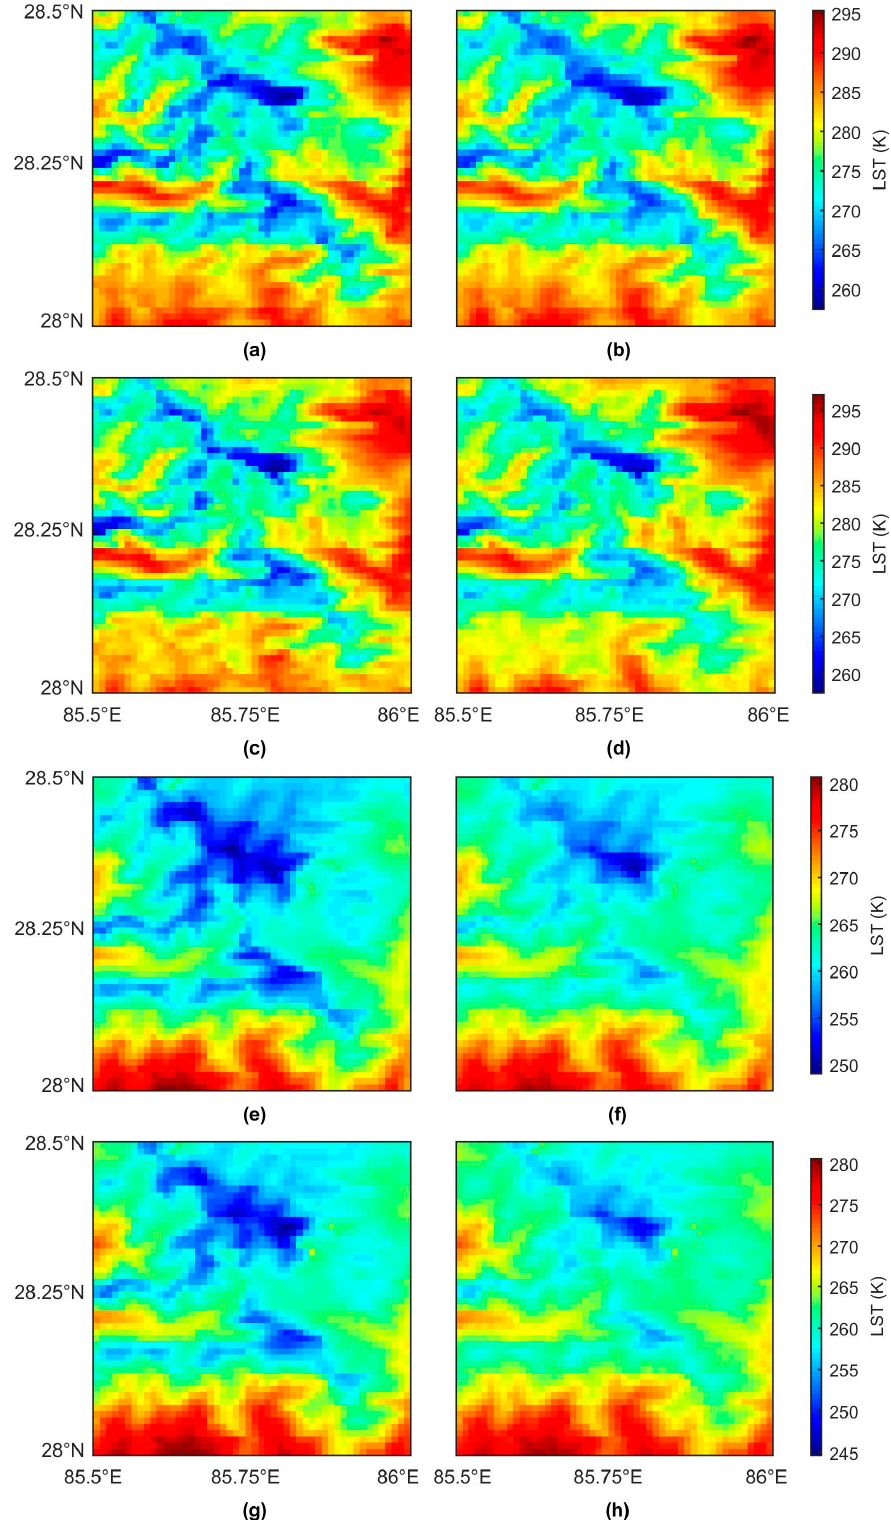
Figure 3. Spatial distribution patterns of annual mean land surface temperature (LST) from the moderate-resolution imaging spectroradiometer (MODIS) before and after reconstruction obtained from: ( a ) original MOD11A1 at daytime; ( b ) reconstructed MOD11A1 at daytime; ( c ) original MYD11A1 at daytime; ( d ) reconstructed MYD11A1 at daytime; ( e ) original MOD11A1 at nighttime; ( f ) reconstructed MOD11A1 at nighttime; ( g ) original MYD11A1at nighttime; and ( h ) reconstructed MYD11A1 at nighttime.